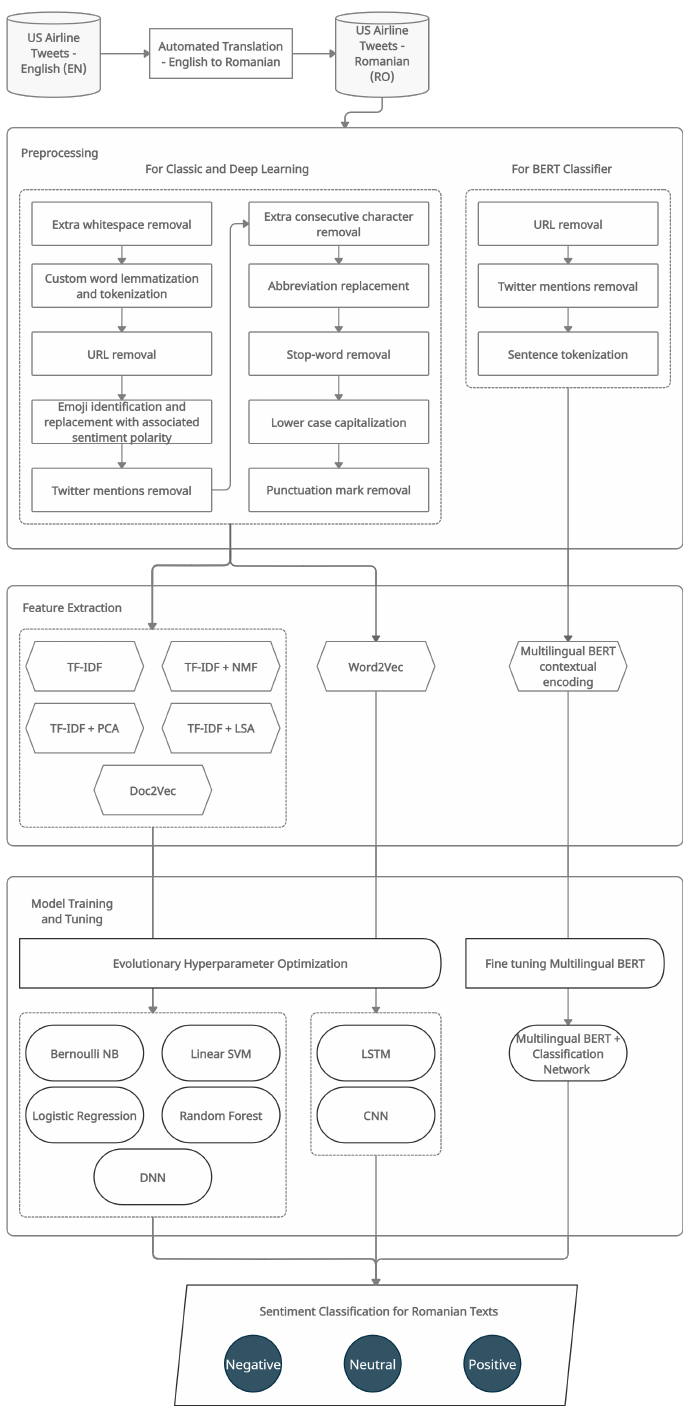
Figure 1. Architecture of the sentiment analysis